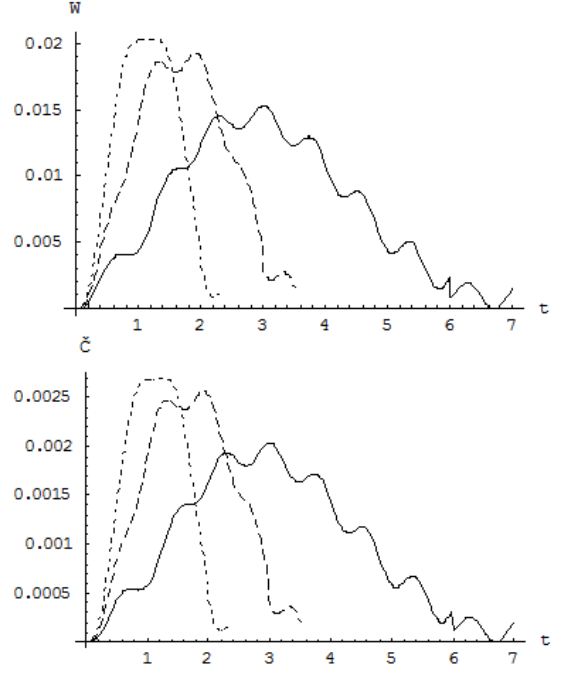
Figure 31: Influence of the speed υ for R = 150 m, d = 5 m, e H = 3.00 m, e V = 1.20 m and υ =10m/s ( __ ), υ = 20 m/s ( _ _ ), and υ = 30 m/s (- - - ).